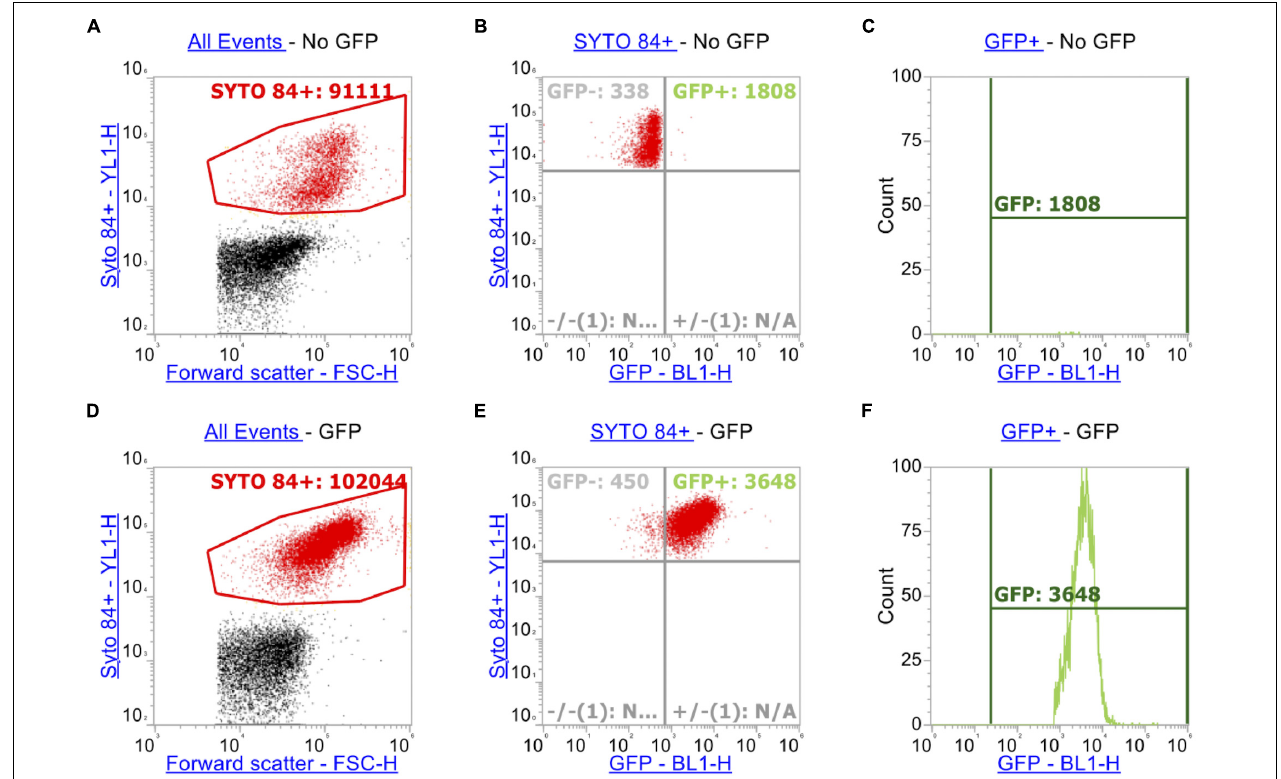
FIGURE 2 | Gating strategy when measuring GFP alongside ethidium bromide. As above, SYTO TM 84 + cells were gated above in red (A,D) . Panels (A–C) represents strain SL1344 expressing no GFP. (B,E) Plots YL1-H for SYTO TM 84 against BL1-H for GFP. Only SYTO TM 84 + cells are analyzed in these plots and the GFP + gate (Blue, right hand side) represents cells that are expressing GFP only and excluding cells fluorescing in BL1-H channel by spillover (C,F) .